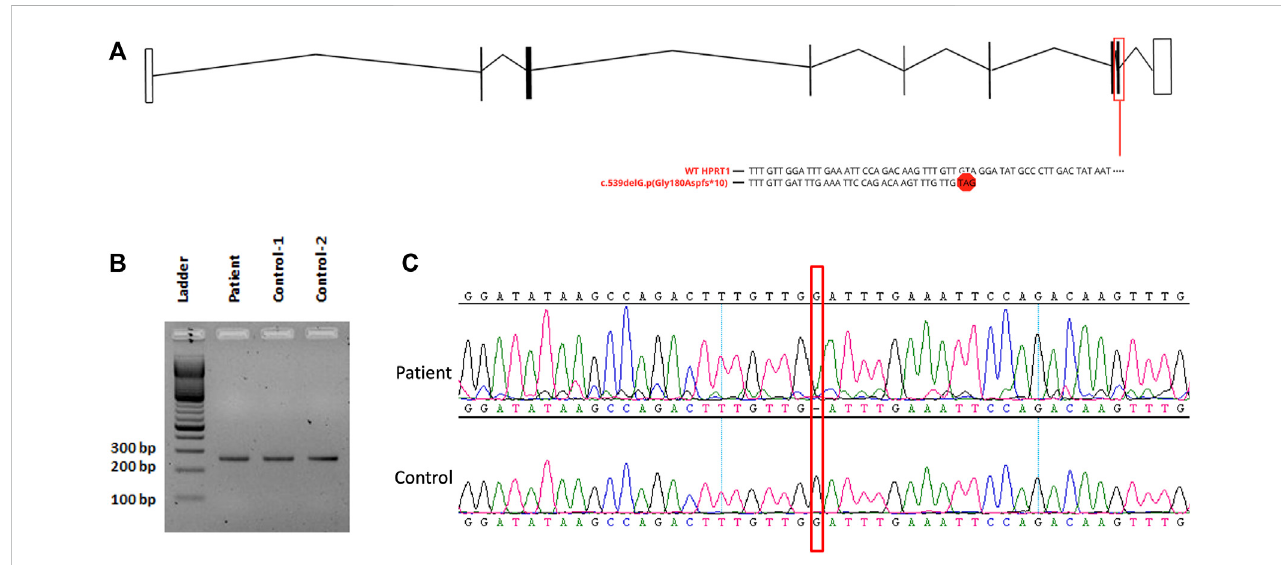
FIGURE 2 (A) Schematic drawing of HPRT1 transcript displaying the affected exon with the variant. (B) Analysis of RT-PCR on fi broblast-derived RNA, followed by 2% agarose gel electrophoresis. (C) Sanger sequencing for cDNA showing the presence of the mutant